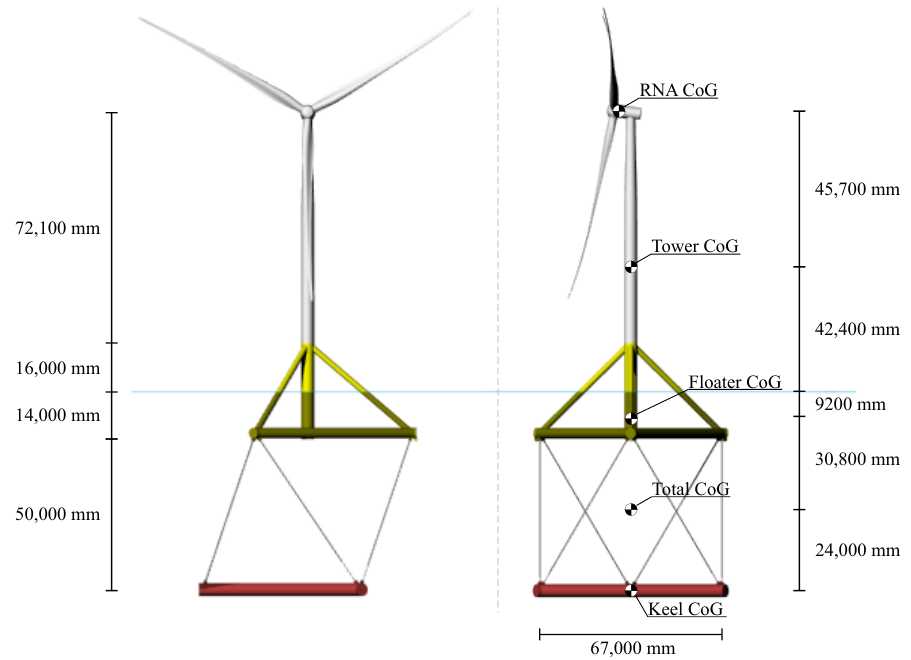
Figure 3. Definition of structure and centre of gravity (CoGs).